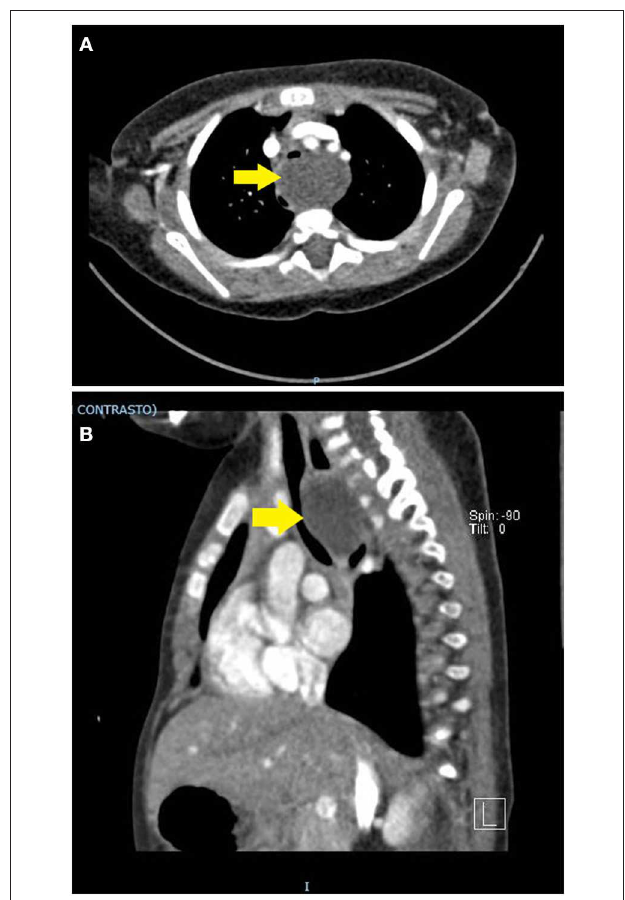
FIGURE 2 | (A,B) Contrast-enhanced chest CT scan. A thin-walled round mass (antero-posterior to lateral diameter, size 30 × 25 × 40mm) can be seen at the level of the first five dorsal vertebral somas (from D1 to D5). The mass (yellow arrow) occupies the upper and middle mediastinum, displacing the esophagus posteriorly and the trachea anteriorly. In dynamic acquisitions a marked reduction in the size of the trachea to the middle third is documented. The epiaortic vessels appear to be slightly displaced anteriorly without reduction in